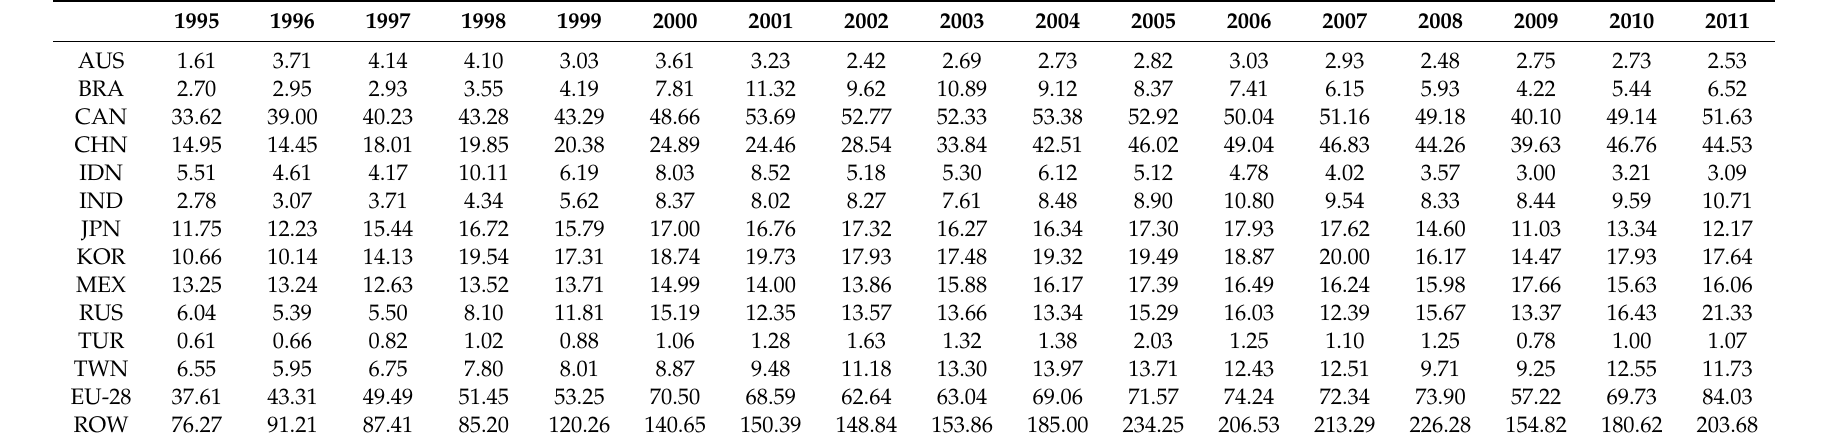
Table A5. US’s virtual oil imports